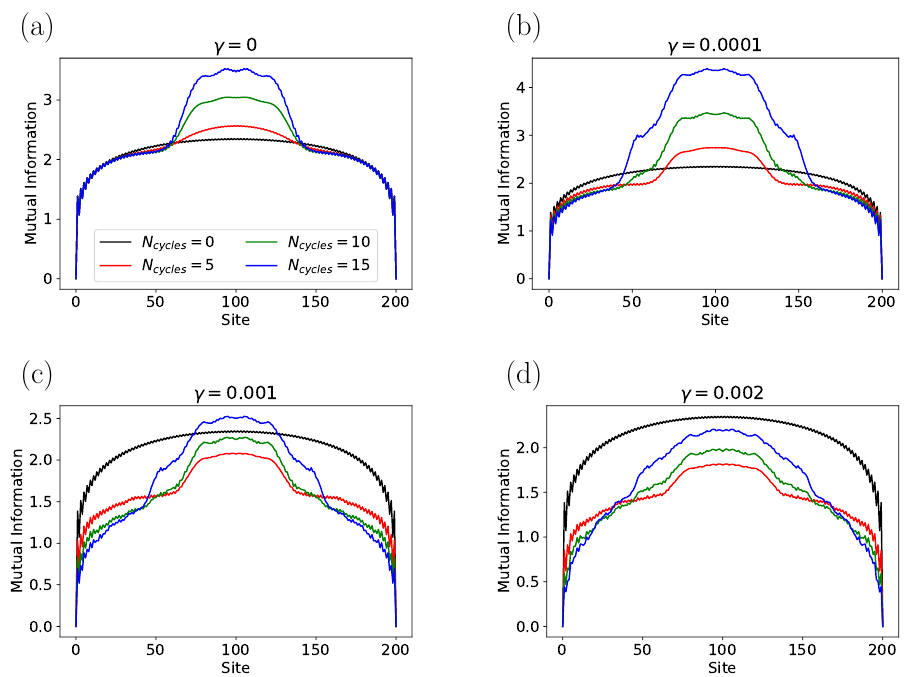
/ L = 0.9, T / L = 0.1 0 1 / R = Γ R = R Γ L / R , with Γ L − with + + +